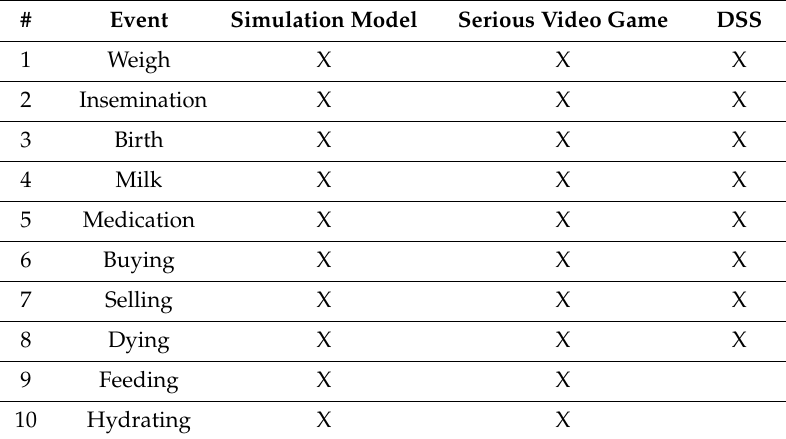
Table 1. Events present in each of the developed